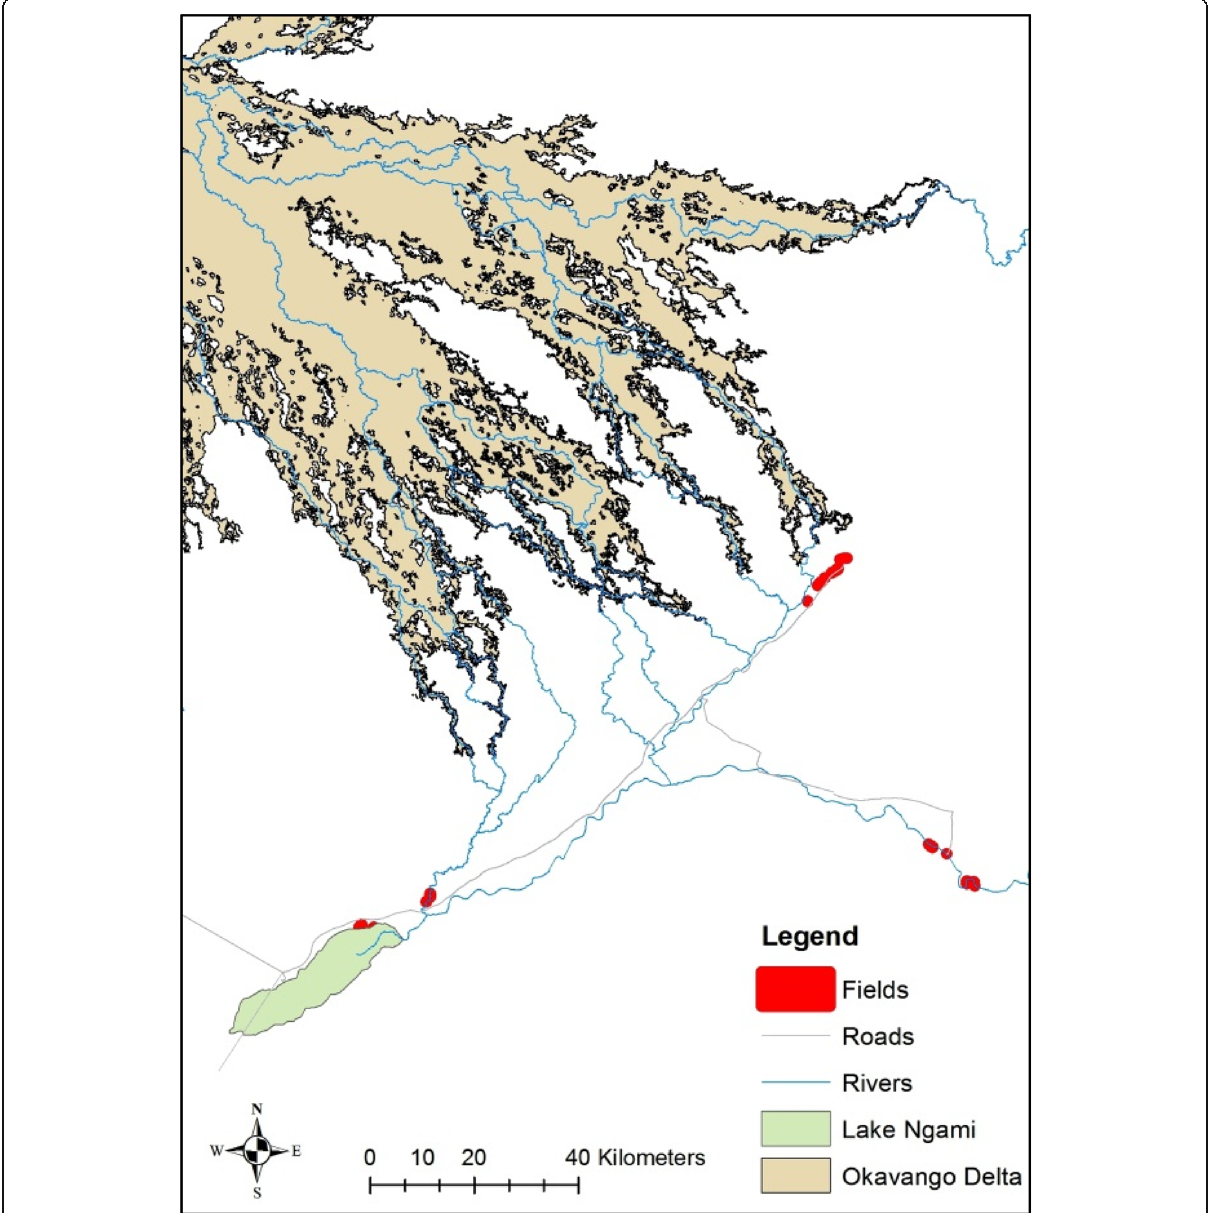
Fig. 2 The distribution of sampled molapo fields at Shorobe, Makalamabedi and Lake